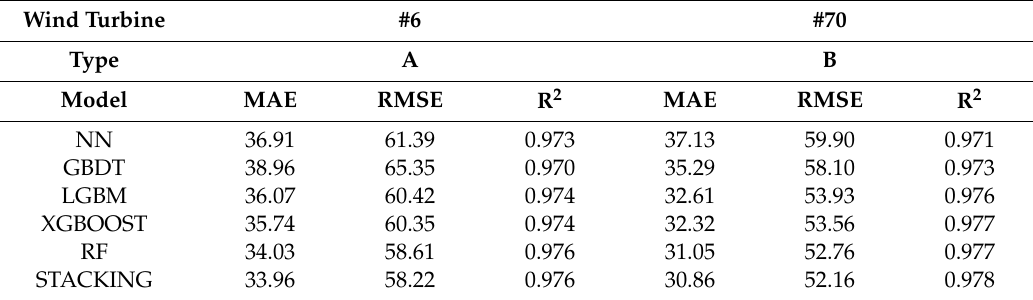
Table 4. Performances of di ff erent models on test data.